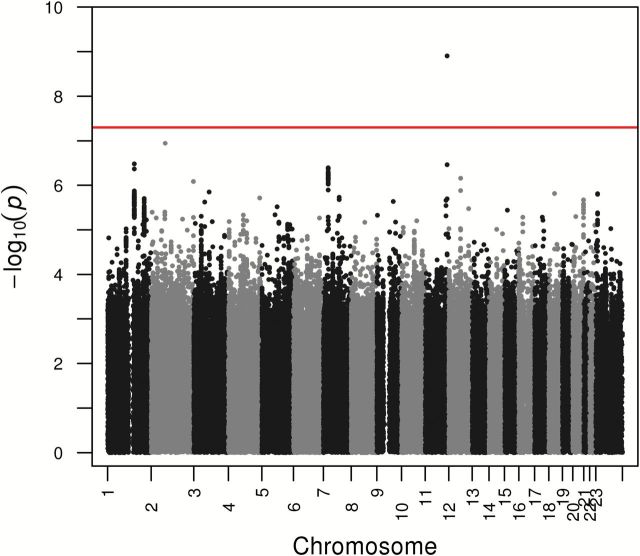
Association plot for combined GWAS and COGS analyses for estrogen receptor (ER)–negative cases. The P values of the association between each single nucleotide polymorphism (SNP) and breast cancer survival were obtained by cox regression analyses with adjustment for principle components for each study and then combined. The y-axis shows the -log10
P values of each SNP analyzed, and the x-axis shows their chromosome position. The red horizontal line represents P = 5x10-8. All statistical tests were two-sided.